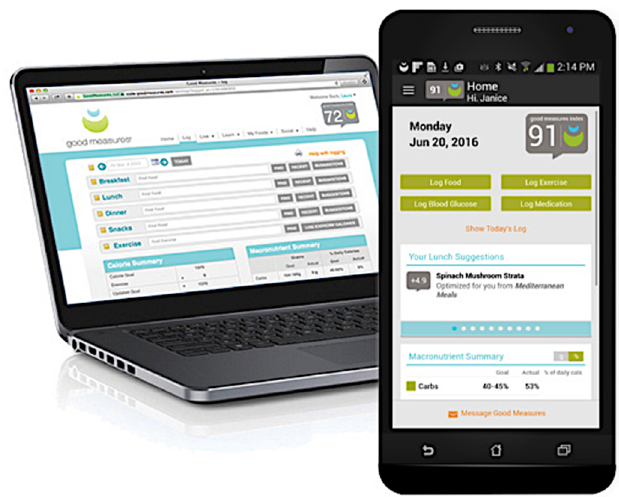
Figure 1. Good Measures Application shown in Mobile and Computer Format. Note: Written permission to use the Good Measures image is on file.